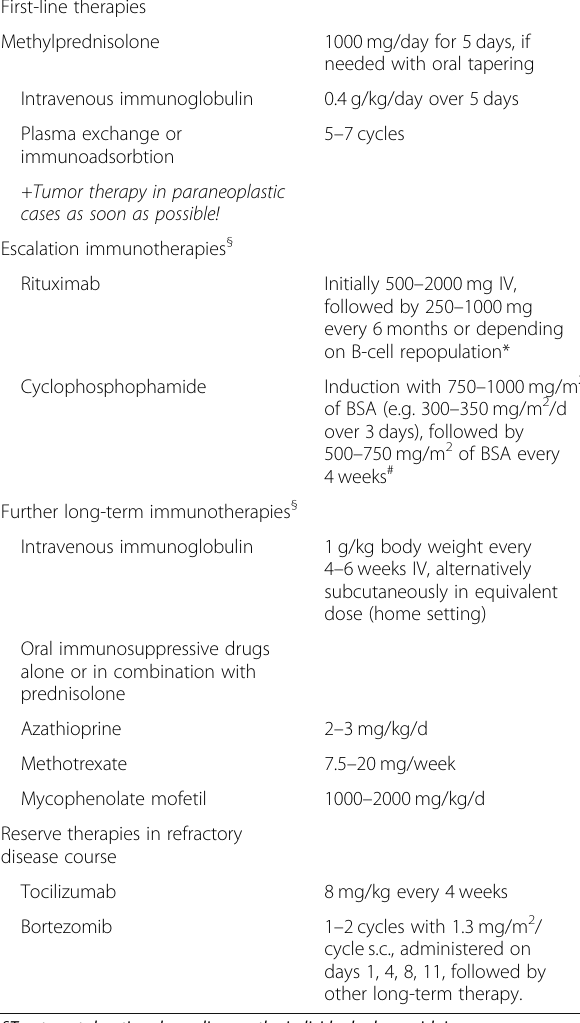
Table 1 Standard therapeutic approach and escalation